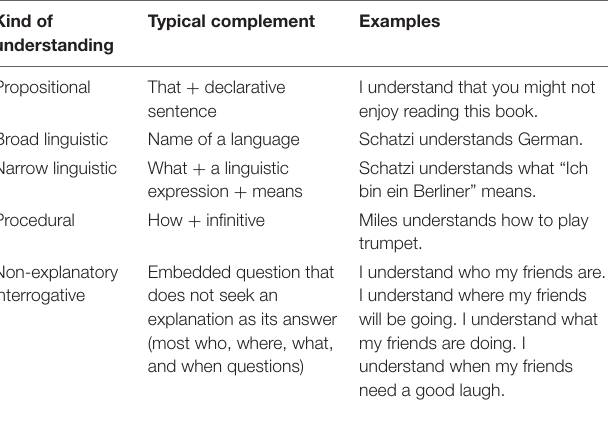
contributions. Moreover, these scientific disciplines may